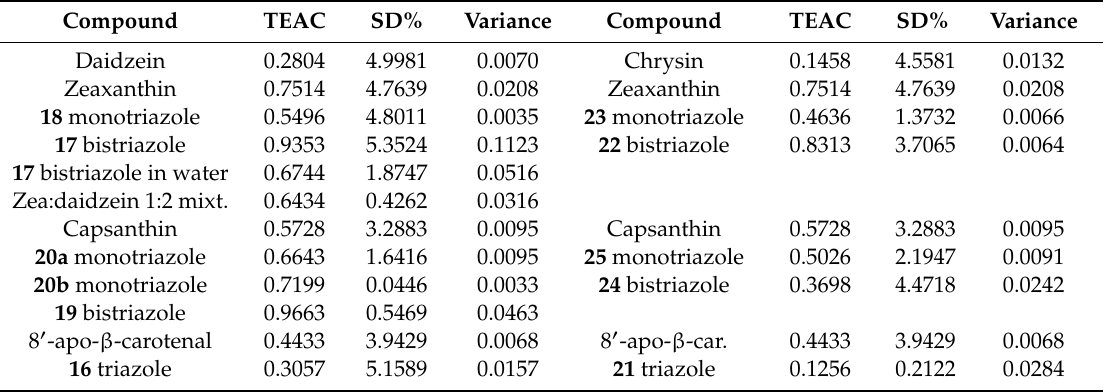
Figure 3. TEAC values of the parent flavonoids and carotenoids, as well as those of their conjugates. The error bars show the standard deviation. * indicates significant differences compared to the parent carotenoid ( p < 0.05). Table 2. The TEAC values, standard deviations, and variance by the ANOVA